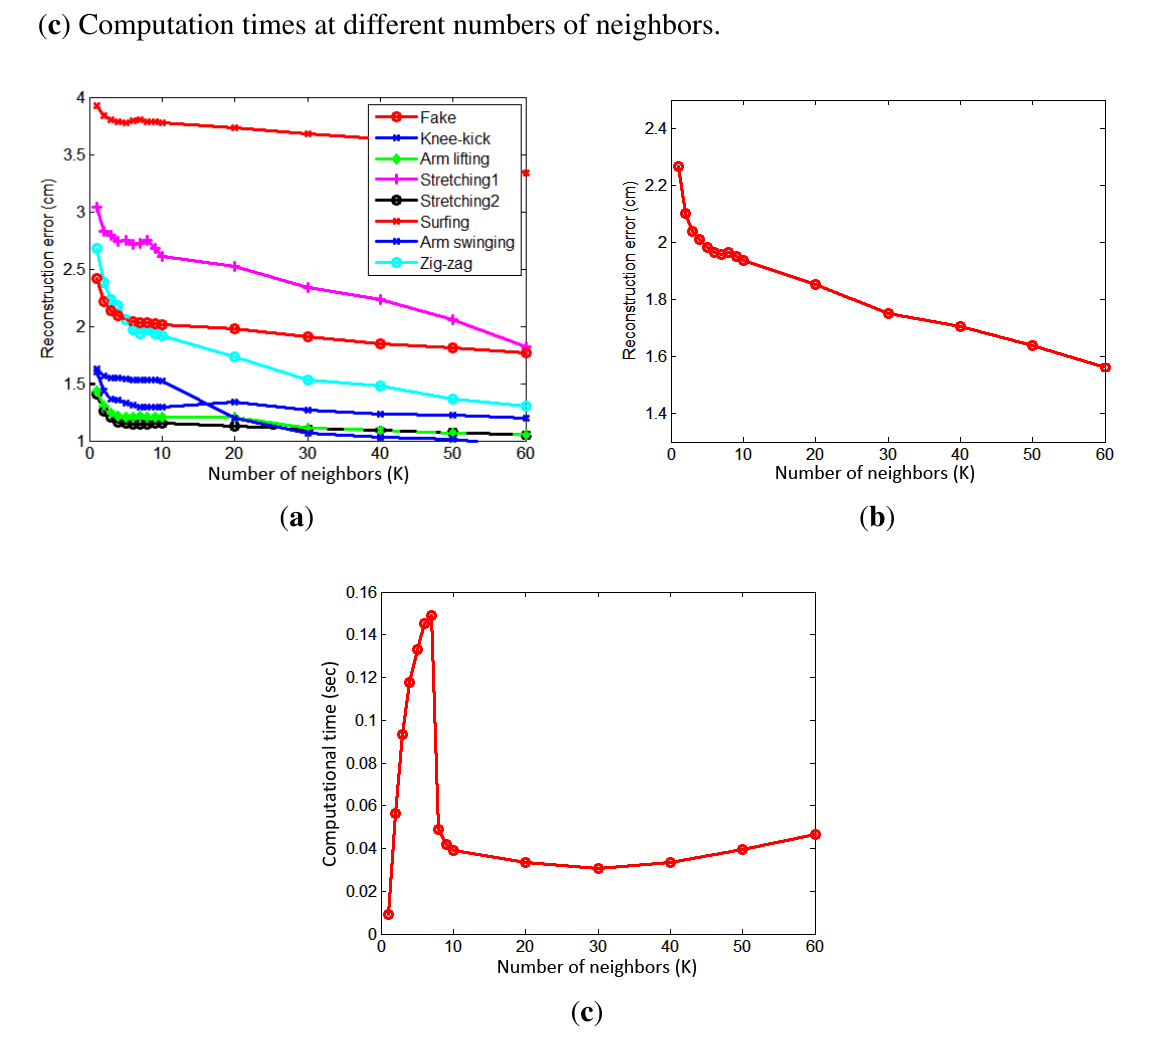
Figure 8. ( a ) Reconstruction errors of eight actions at different numbers of neighbors. ( b ) Average reconstruction errors of all eight actions at different numbers of neighbors. ( c ) Computation times at different numbers of